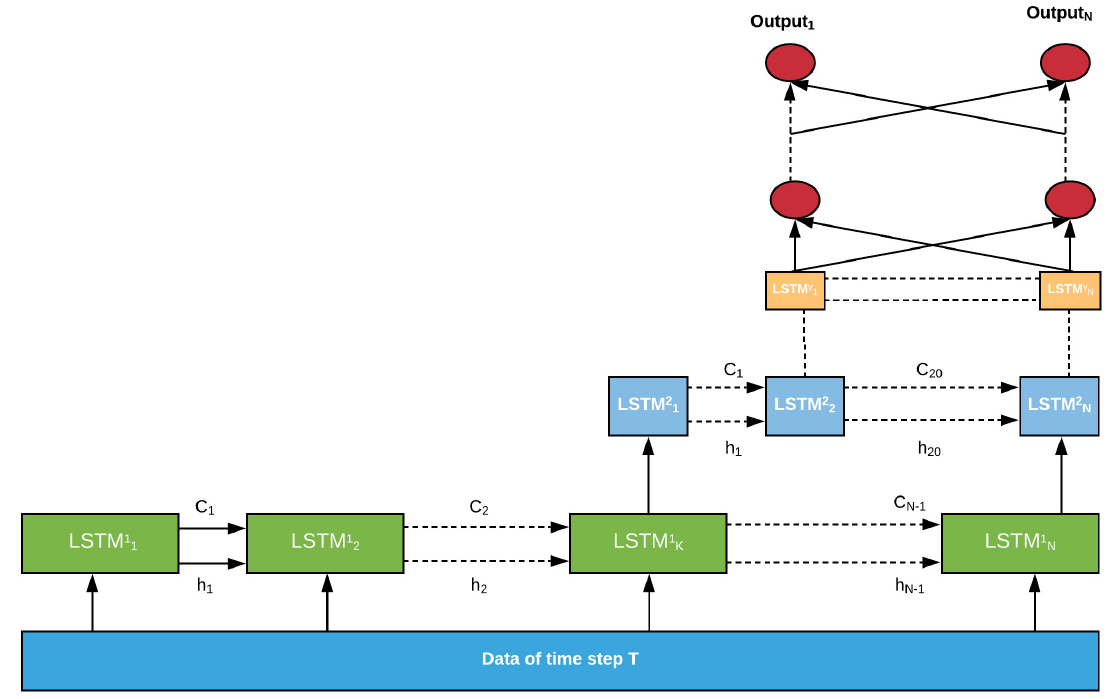
Figure 2: General LSTM based learning